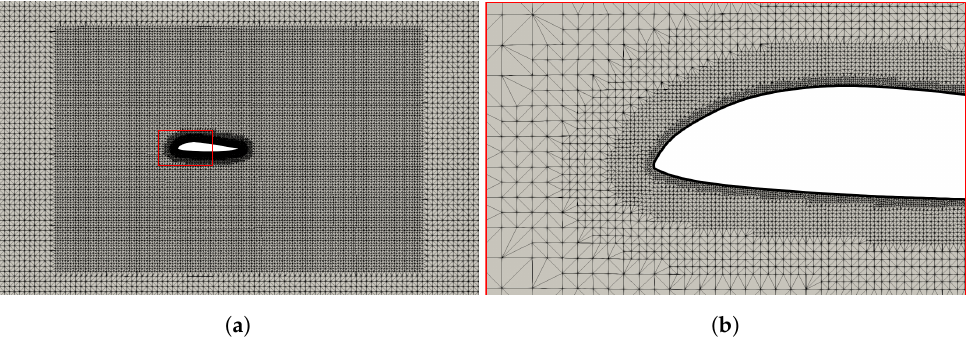
Figure 5. Computational domain for the BWB aircraft CFD simulation with boundary conditions.